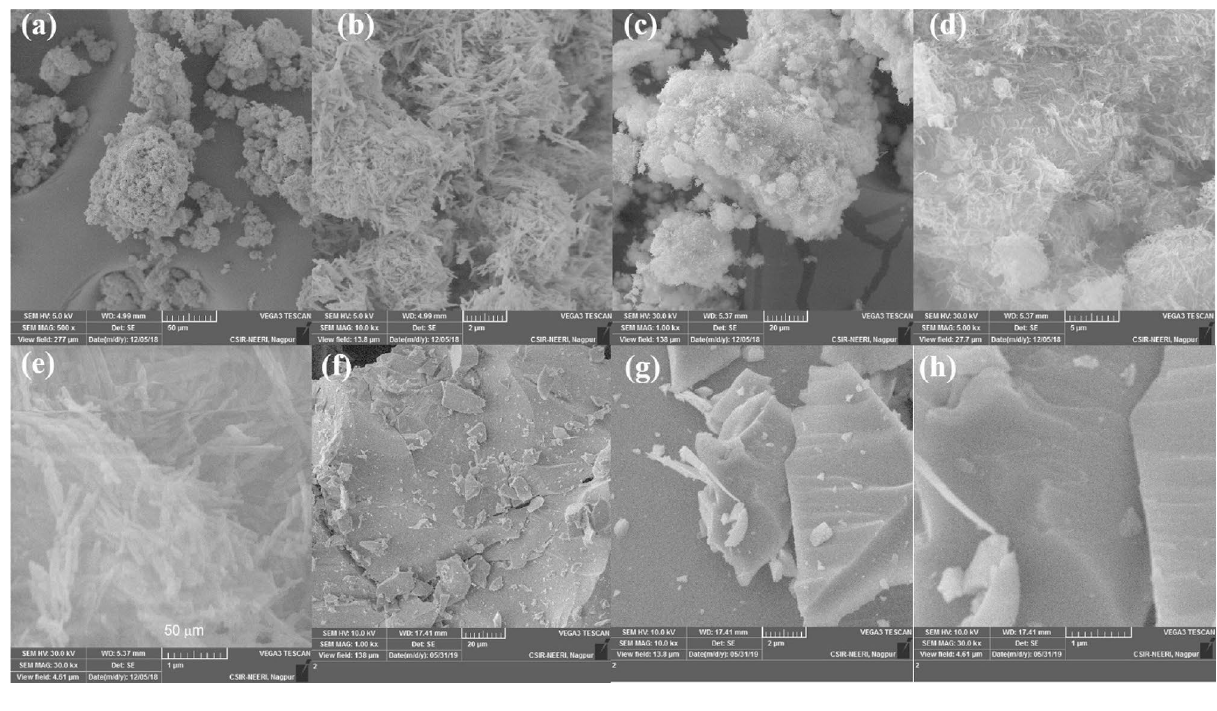
Figure 3. SEM images of Ni 2 P/CdS ( a – d) and Pt/TiO 2 ( e – h) .